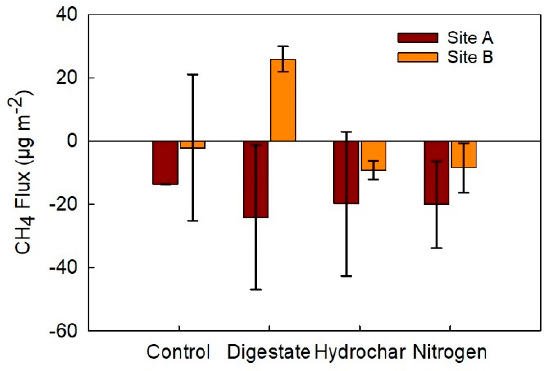
Figure 8. Cumulative CH 4 fluxes in µ g m − 2 from subplots in sites A and B treated with digestate, hydrochar, urea (nitrogen), and the control treatment from June–October 2018. Values show a mean across two replicated plots with error bars representing the standard error.